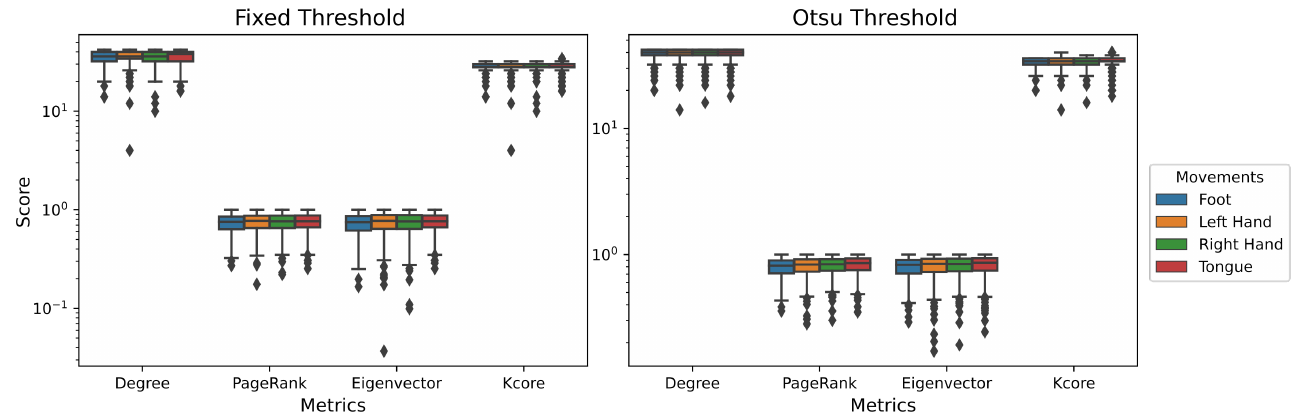
Figure 8. Multilayer graph metric distributions for all four MI classes. After applying a one-way ANOVA test, Otsu’s threshold showed significant values ( p < 0.05) for k -core and degree, while fixed threshold only k -core was significantly different ( p < 0.05).